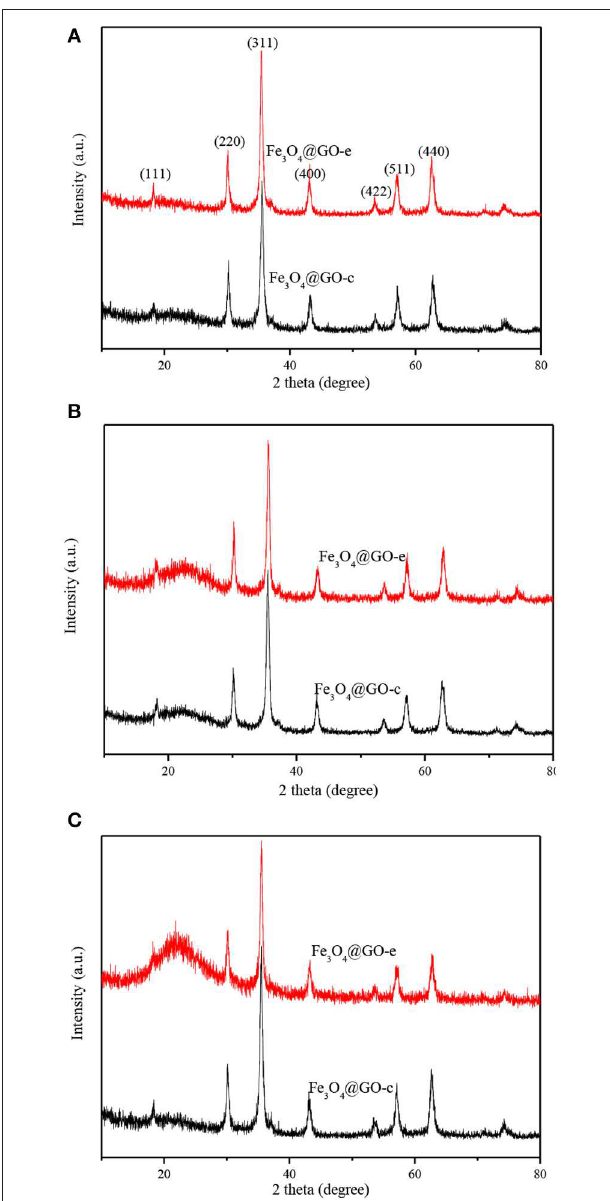
FIGURE 4 | XRD patterns of Fe 3 O 4 @GO-e and Fe 3 O 4 @GO-c (A) , and Fe 3 O 4 @GO-e and Fe 3 O 4 @GO-c after five adsorption-desorption cycles toward MB (B) and Pb(II) (C) .